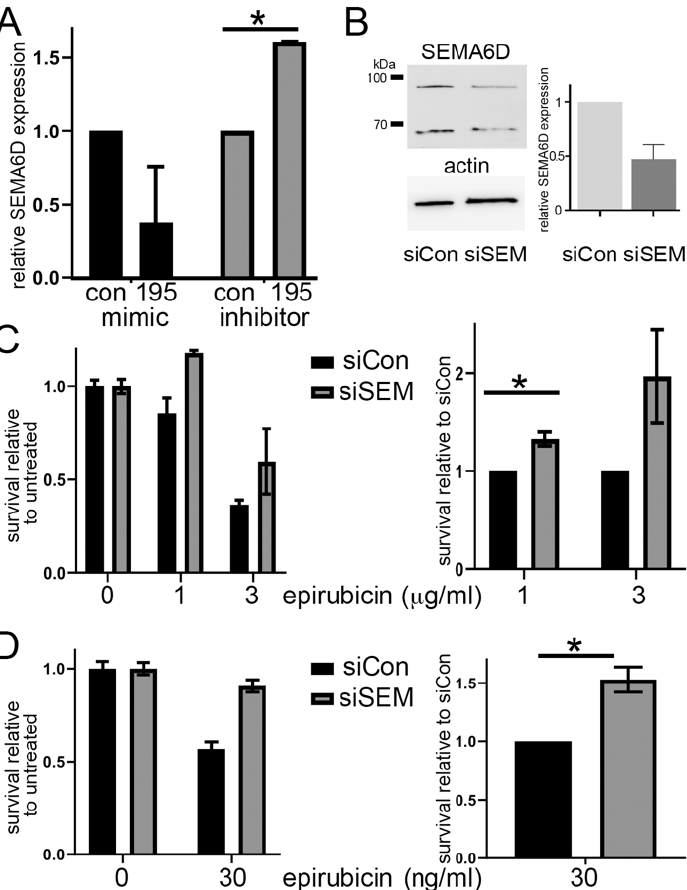
Figure 3. SEMA6D is a target of miR ‐ 195 and modifies chemoresponse. ( A ) The MCF7 cells were transfected with miR ‐ 195 mimics, inhibitors or controls. Relative SEMA6D expression was deter ‐ mined 72 h after transfection by qPCR. Data represent means (+/ − SEM) of two biological repeats. Differences between targeted mimic/inhibitor and appropriate control were tested using paired 1 ‐ tailed t tests; * indicates p < 0.05. ( B ) The MCF7 cells were transfected with siRNA targeted against SEMA6D or the scrambled control. Proteins were extracted after 72 h and Western blots were per ‐ formed for SEMA6D or actin (loading control). Relative SEMA6D expression was quantified using densitometry. Data represent 2 independent biological experiments (mean +/ − SEM). ( C and D ) The MCF7 cells were transfected with siRNA targeted against SEMA6D or the scrambled control and treated with doses of epirubicin as indicated, or with vehicle control. Relative survival was deter ‐ mined using MTT ( C ) or colony forming assays ( D ). Data are presented in two separate plots: left, relative to untreated (vehicle control), with 1 biological repeat showing error bars representing the SD of replicate wells; right, relative to siRNA controls, representative of means of 2 (panel C) or 3 (panel D) biological replicates, with error bars representing the SEM of biological replicates. Differ ‐ ences between targeted siRNA and control were tested using paired 1 ‐ tailed t tests; * indicates p < 0.05. Our next aim was to test whether SEMA6D expression directly influenced chemoresponse in accordance with a function downstream of miR ‐ 195. We transiently transfected MCF7 cells with siRNAs targeting SEMA6D or a non ‐ targeting control and confirmed that the siRNA effectively knocked ‐ down SEMA6D expression. The SEMA6D was expressed as two specific protein species, as detected by an antibody recognizing the N ‐ terminus; expression of both was reduced by the targeted siRNAs (Figure 3B). Then, we repeated these transfections and assessed sensitivity to epirubicin as previously, using either MTT assays (Figure 3C) or clonogenic survival assays (Figure 3D). Cells with re ‐ duced expression of SEMA6D were significantly more resistant to epirubicin both at the lower dose for the MTT assays ( p < 0.05) and in the clonogenic survival assays ( p < 0.01). We concluded that reduced SEMA6D expression caused relative epirubicin resistance, and therefore that miR ‐ 195 mediates chemoresponse, at least in part, through SEMA6D.